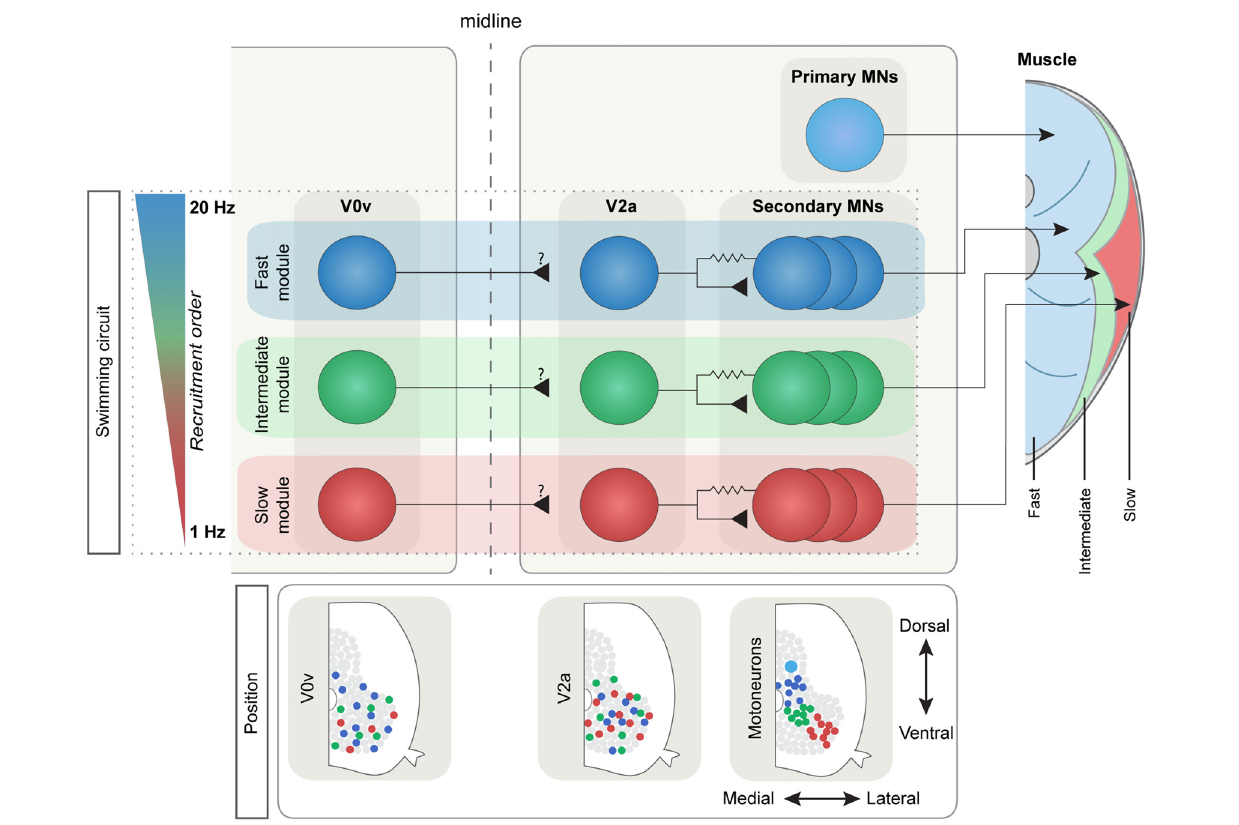
FIGURE 2 | The modular swim network in adult zebrafish. The IN and MN populations in the adult zebrafish are subdivided into three main types depending on the recruitment frequency: slow (red), intermediate (green) and fast (blue). This subdivision reflects the three distinct muscle types that in zebrafish are spatially segregated (right): the anaerobic “white” fibers (in blue), the aerobic “red” fibers (in red) and the intermediate fibers (in green). The main ipsilateral excitatory drive comes from the V2a population that is connected preferentially to MNs belonging to the same module through mixed chemical and electrical synapses. The V0v population in adult zebrafish also shows a differential speed-depended recruitment order, although its connectivity has not been yet defined. Bottom: MN pools are spatially defined, while V0v and V2a INs have lost their topographical organization during development.